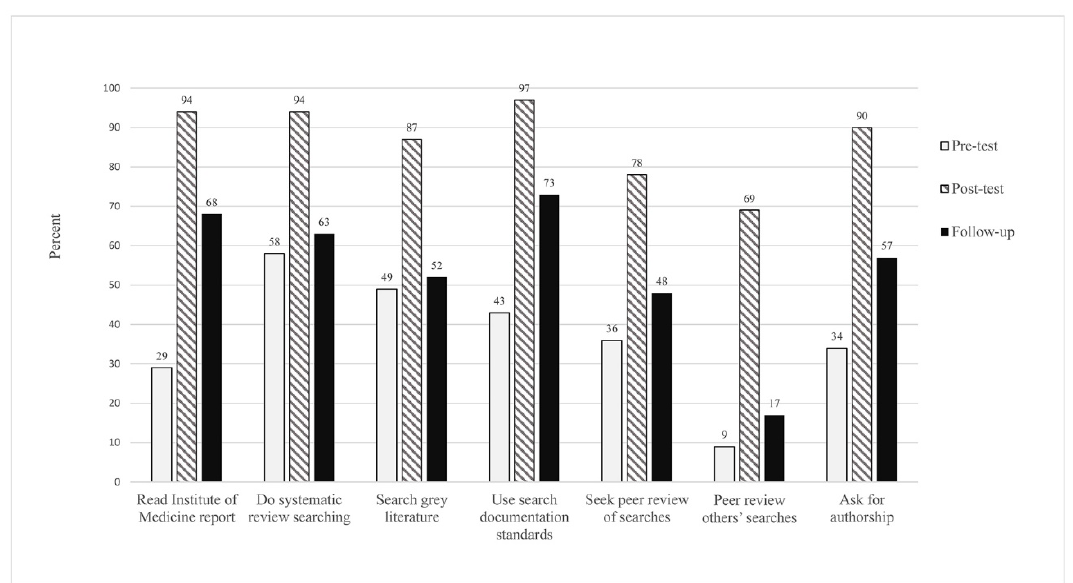
Figure 1 Systematic review behaviors (reported at pre-class and follow-up) and intention to engage in behaviors (reported at